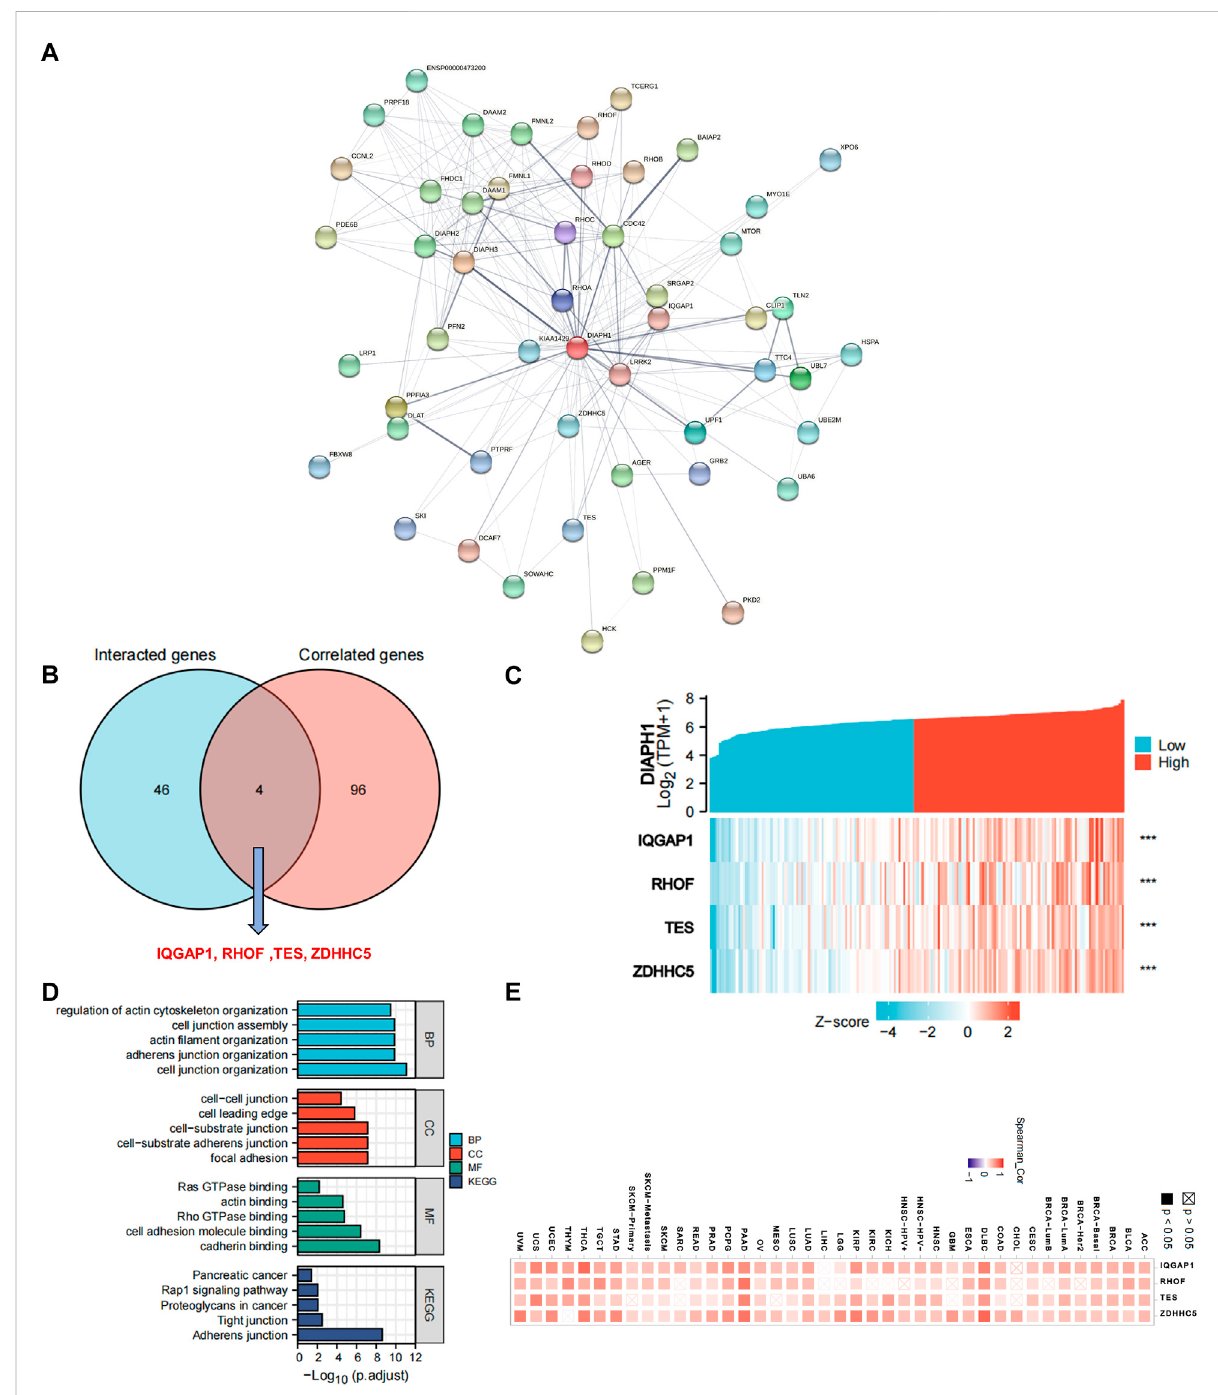
FIGURE 4 DIAPH1-related gene network, KEGG pathway analysis, and GO enrichment analysis. (A) A total of 50 available experimentally determined DIAPH1-interacting proteins using STRING tool. (B) An intersection analysis of the DIAPH1-interacting and -correlated genes. (C) The correlation between DIAPH1 expression and four intersected genes expression in PAAD. *** p < 0.001, in Spearman ’ s rho. TPM, transcripts per million. (D) GO enrichment and KEGG pathway analyses based on the DIAPH1-interacting and -correlated genes. Adjusted p -values were obtained from multiple hypotheses test using the Benjamini – Hochberg procedure; p . adjust < 0.05 was considered statistically signi fi cant. (E) Correlation between DIAPH1 and intersected four genes expression in pan-cancer, in purity-adjusted partial Spearman ’ s